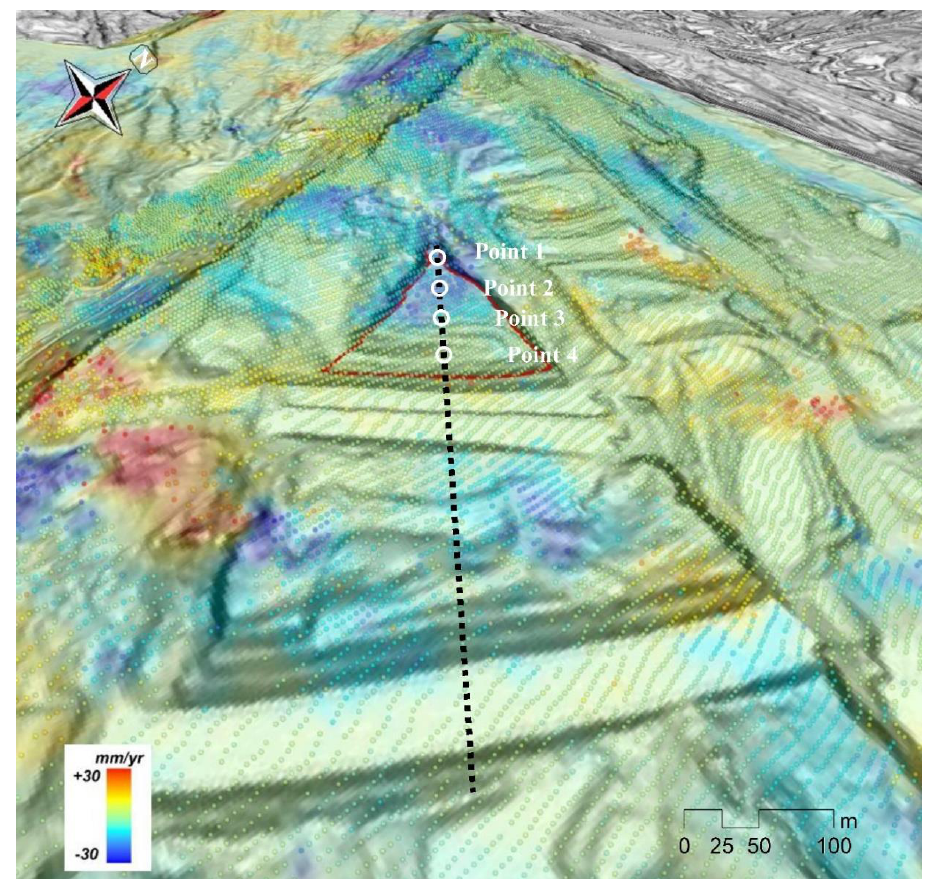
Figure 7. Mean LOS deformation velocity map of the artificial side slope over Freeway No. 3 in 3D perspective. The color image and point of deformation is draped on the top of topography. The negative LOS displacement (blue) represents movement away from the satellite and indicates downslope movement. The red solid line outlines the area of landslide. The white circles indicate the location of selected points in (Figure 9). The black dash line marks the location displacement profile shown in Figures 2 and